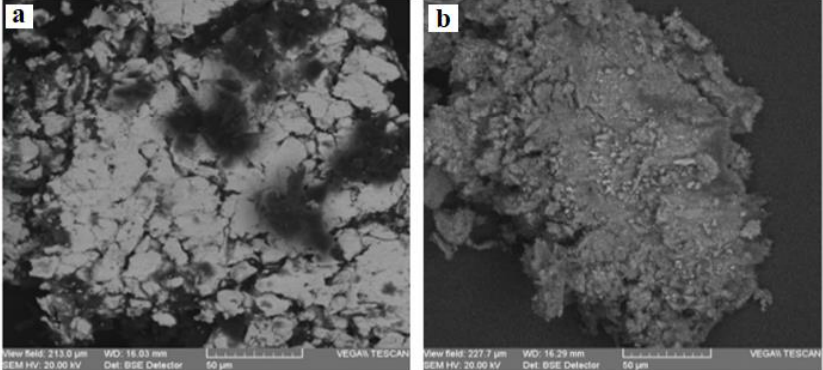
Figure 10. SEM microphotographs ( × 500, BSE) for the inks of document S2: ( a ) S2-CA; ( b ) S2-CN. The EDX spectra provided the elemental composition of the structural components of the two documents, as presented in Table 1. Table 1. The elemental composition in gravimetric percentages for the samples collected from the two documents under scrutiny and indexed according to the area and type of material. Sample